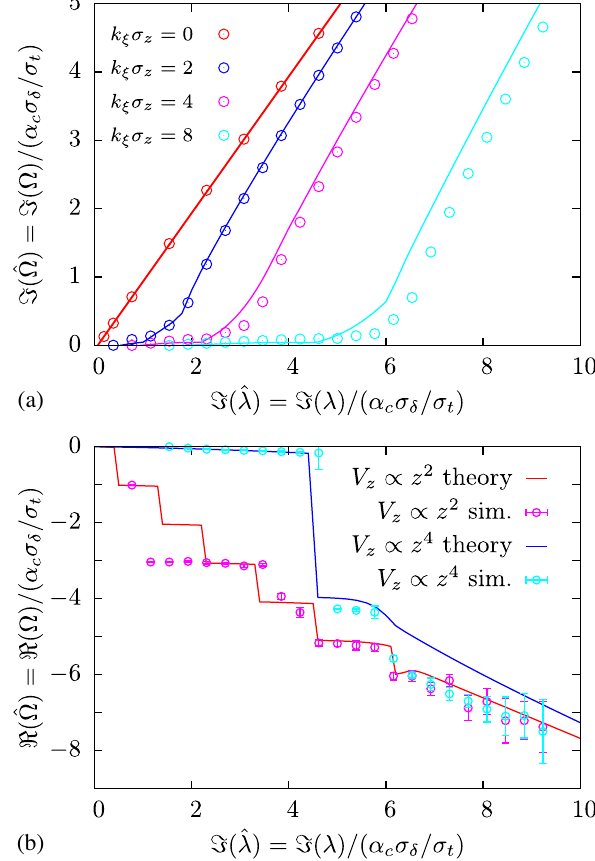
FIG. 7. Comparison of the unstable dynamics obtained by tracking (dots) to those of theory (solid lines) when the longitudinal damping and diffusion are neglected. Panel (a) com- pares the predicted multibunch growth rate in the quartic potential ∝ z 4 for four different values of k σ V . The comparison is rather ξ z z good and quite similar to that in Fig. 3(a). Panel (b) plots the 8 for the quadratic unstable frequency shift from ω β when k ξ σ z ¼ potential (red and magenta) and the quartic potential (blue, cyan). The frequency shift is approximately an integer multiple of α σ σ when ℑ ð λ Þ ≲ 3 ξω 0 σ δ = 4 , while for larger values of the δ = c t instability strength ℜ ð Ω Þ smoothly decreases with ℑ ð λ Þ and is largely independent of V z